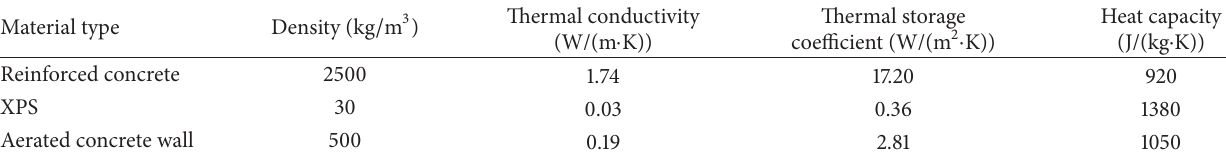
Table 9: Thermophysical parameters of the materials.